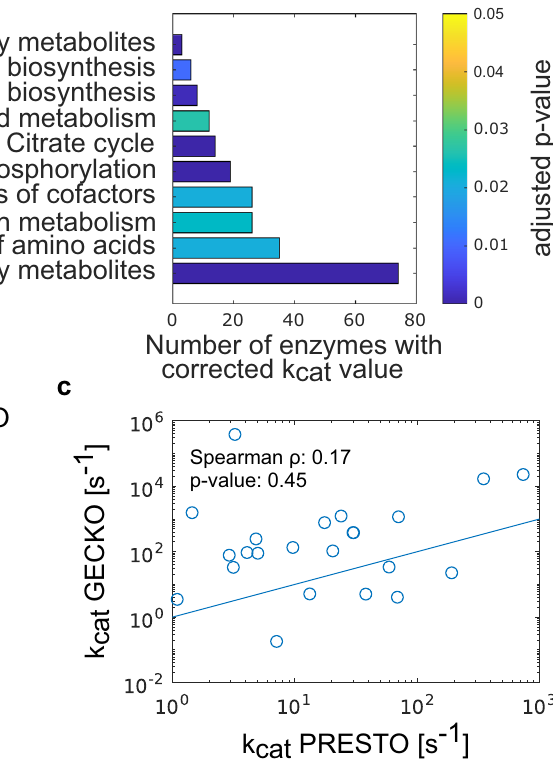
showing the overlap of enzymes whose k cat values were manually corrected 7 ( “ Manual ” ), automatically corrected by the GECKO heuristic in any of the condi- tions ( “ GECKO ” ), or corrected by PRESTO ( “ PRESTO ” ). c Log-transformed k cat values corrected using both the GECKO heuristic and PRESTO are not associated (Spearman correlation coef fi cient of 0.166, p -value=0.45). Source data are pro- vided as a Source Data fi